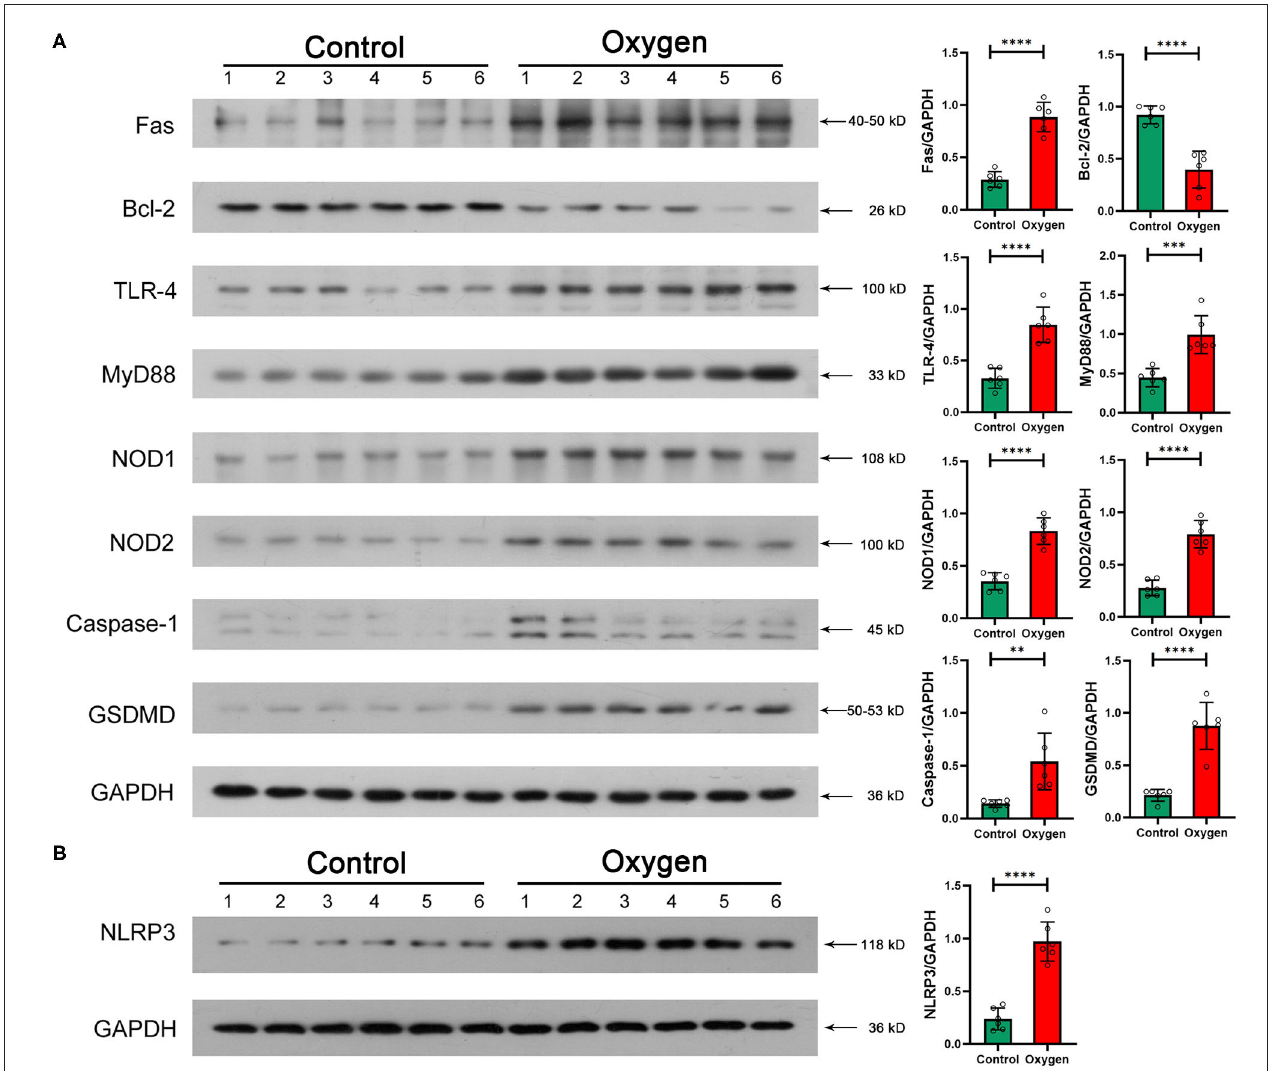
FIGURE 7 | Essential protein levels of innate immune response and enterocyte death induced by hyperoxia ( n = 6). (A) TLR-4, Myd88, NOD1/2, and NLRP3 protein levels in the gut tissue. Oxygen inhalation significantly increased the expression of TLR-4 ( P < 0.0001), Myd88 ( P = 0.0005), NOD1 ( P < 0.0001), NOD2 ( P < 0.0001), and NLRP3 ( P < 0.0001). (B) Fas, Bcl-2, Caspase-1, and GSDMD protein levels in the gut tissue. Administered oxygen significantly increased the expression of Fas ( P < 0.0001), Caspase-1 ( P = 0.0048), and GSDMD ( P < 0.0001) and decreased the expression of Bcl-2 ( P < 0.0001). TLR, toll-like receptor; NOD, nucleotide-binding oligomerization domain; GSDMD, gasdermin-D. ** P < 0.01; *** P < 0.001; **** P <